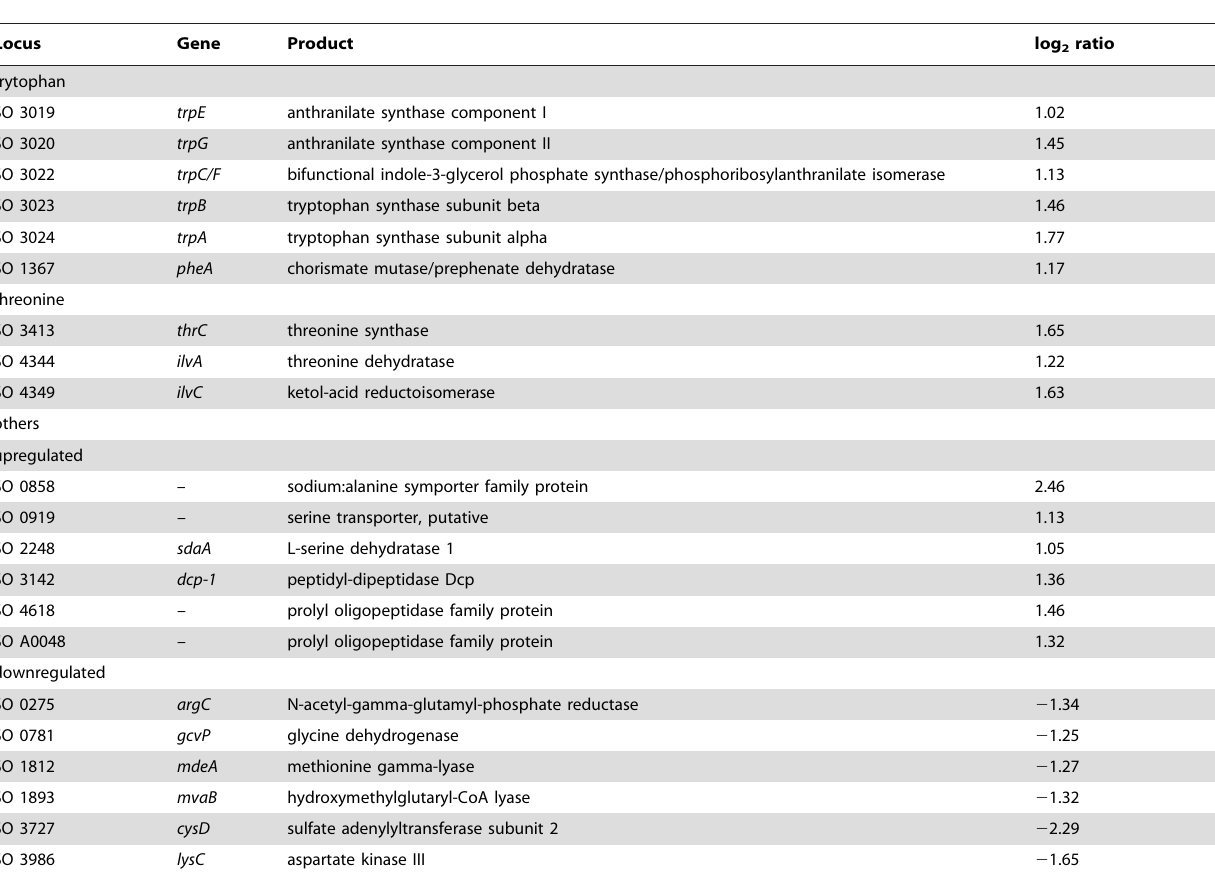
Table 1. Differentially regulated genes related to ‘‘metabolic adaptation’’ – amino acid transport and metabolism.